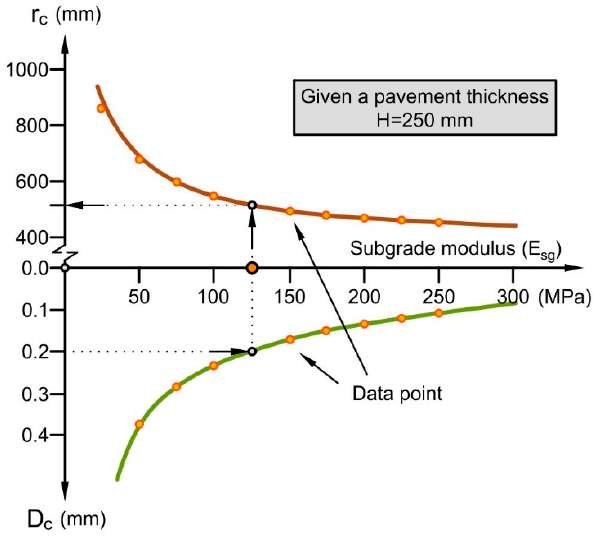
Figure 9. Relationships between 𝑟 (cid:3030) , 𝐷 (cid:3030) , and subgrade modulus [23].